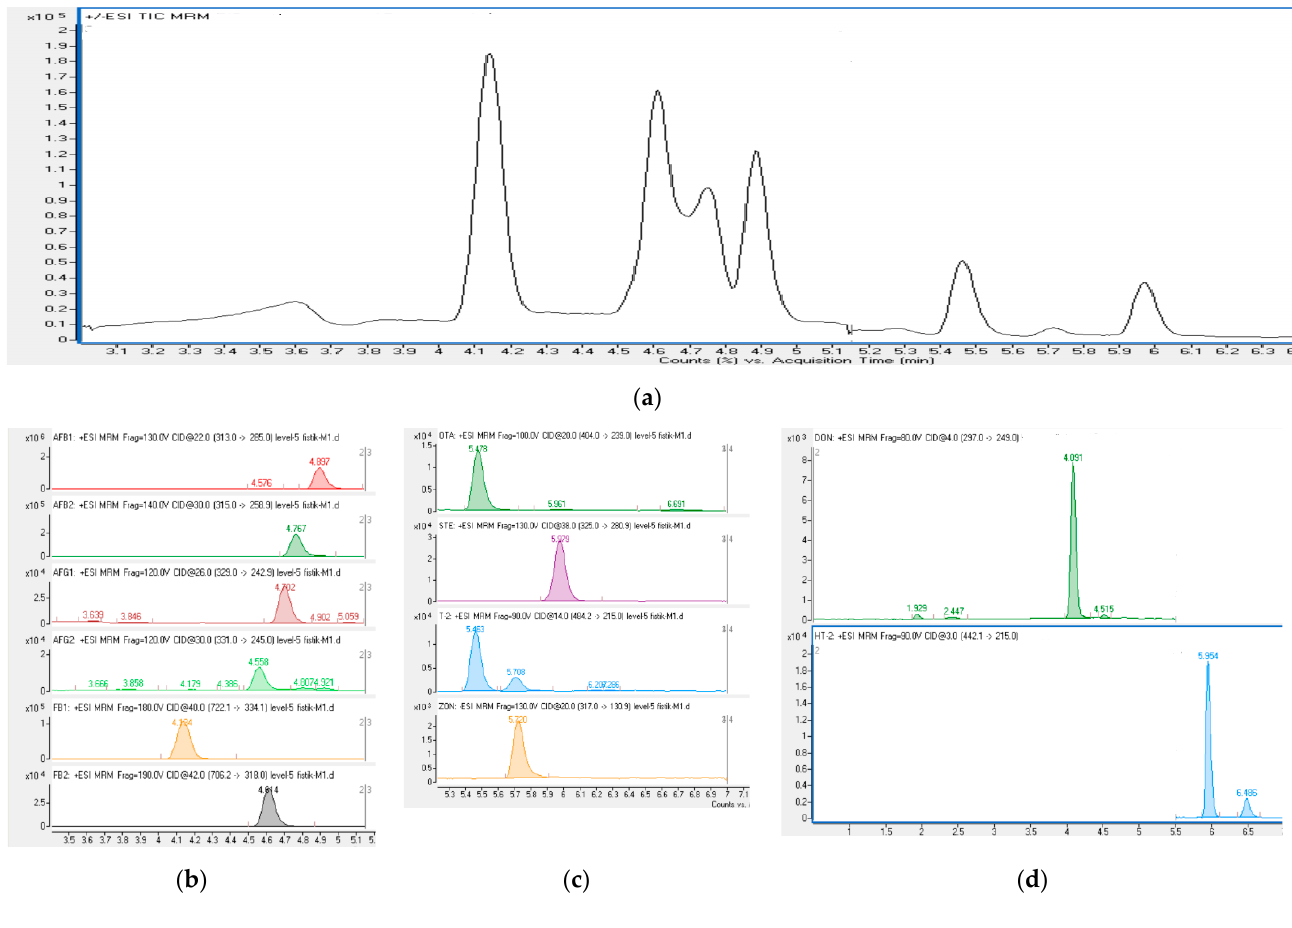
Figure 1. LC − MS/MS chromatograms and TIC of mycotoxins: ( a ) TIC. ( b ) AFB1; aflatoxin B1, AFB2; aflatoxin B2, AFG1; aflatoxin G1, AFG2; aflatoxin G2, FB1; fumonisin B1, FB2; fumonisin B2. ( c ) OTA; ochratoxin A, STE; sterigmatocystin, T2; T-2 toxin, ZON; zearalenone. ( d ) DON; deoxynivalenol and HT2; HT-2 toxin. Table 6. Validation parameters of the LC–MS/MS method applied for nut butter and